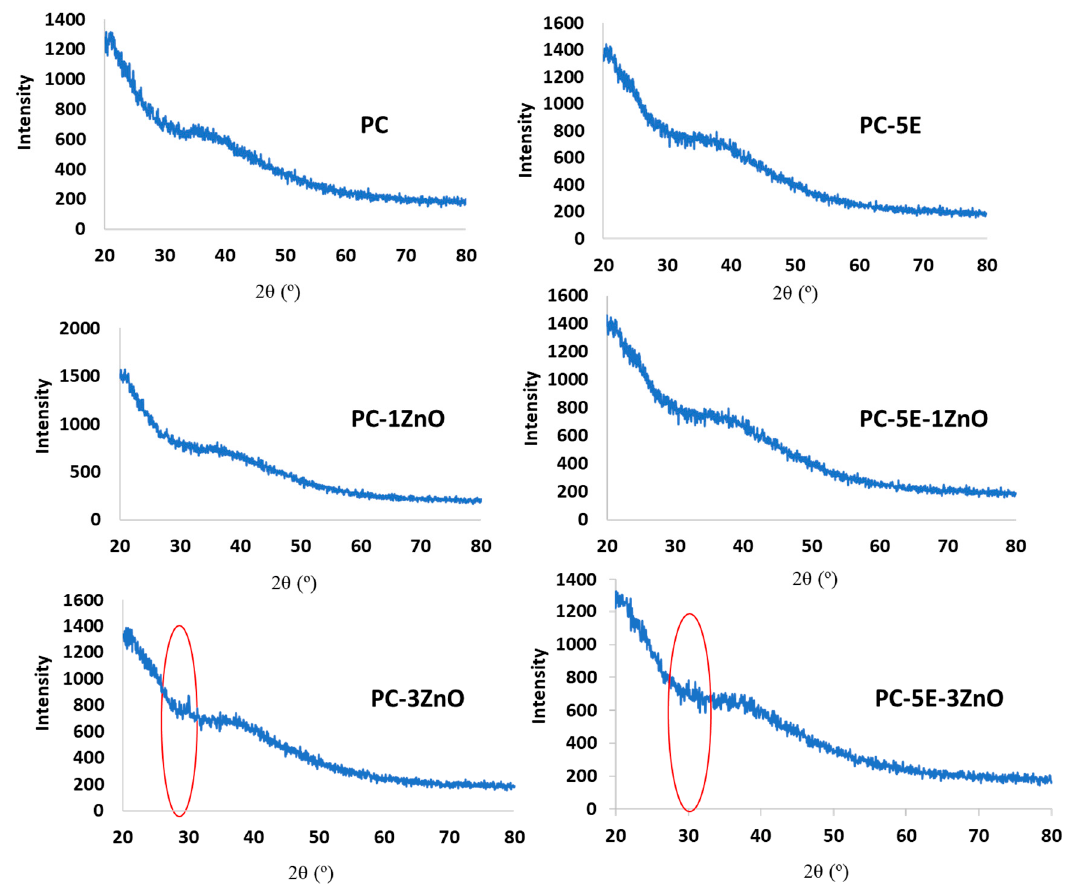
Figure 7. XRD patterns of pectin-based films.